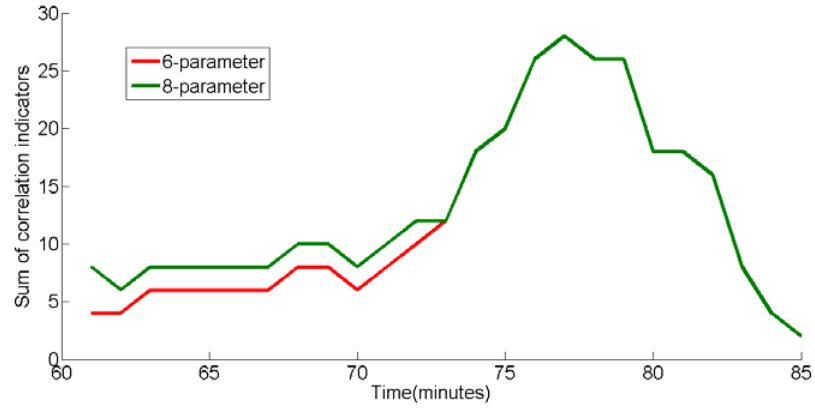
Figure 5. The sum of correlation indicators at each time step in two situations.